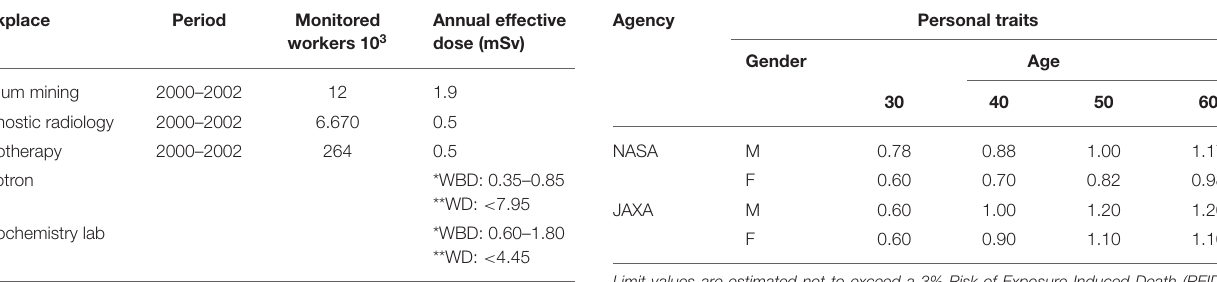
TABLE 2 | The NASA and JAXA career effective dose limits for 1-year mission. Agency